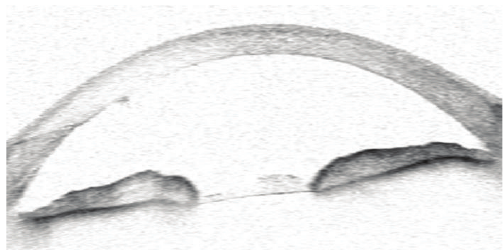
Figure 4: Postoperative anterior chamber optic coherence tomog- raphy picture of the right eye in Case 1. Anterior chamber depth was 2.80 mm.